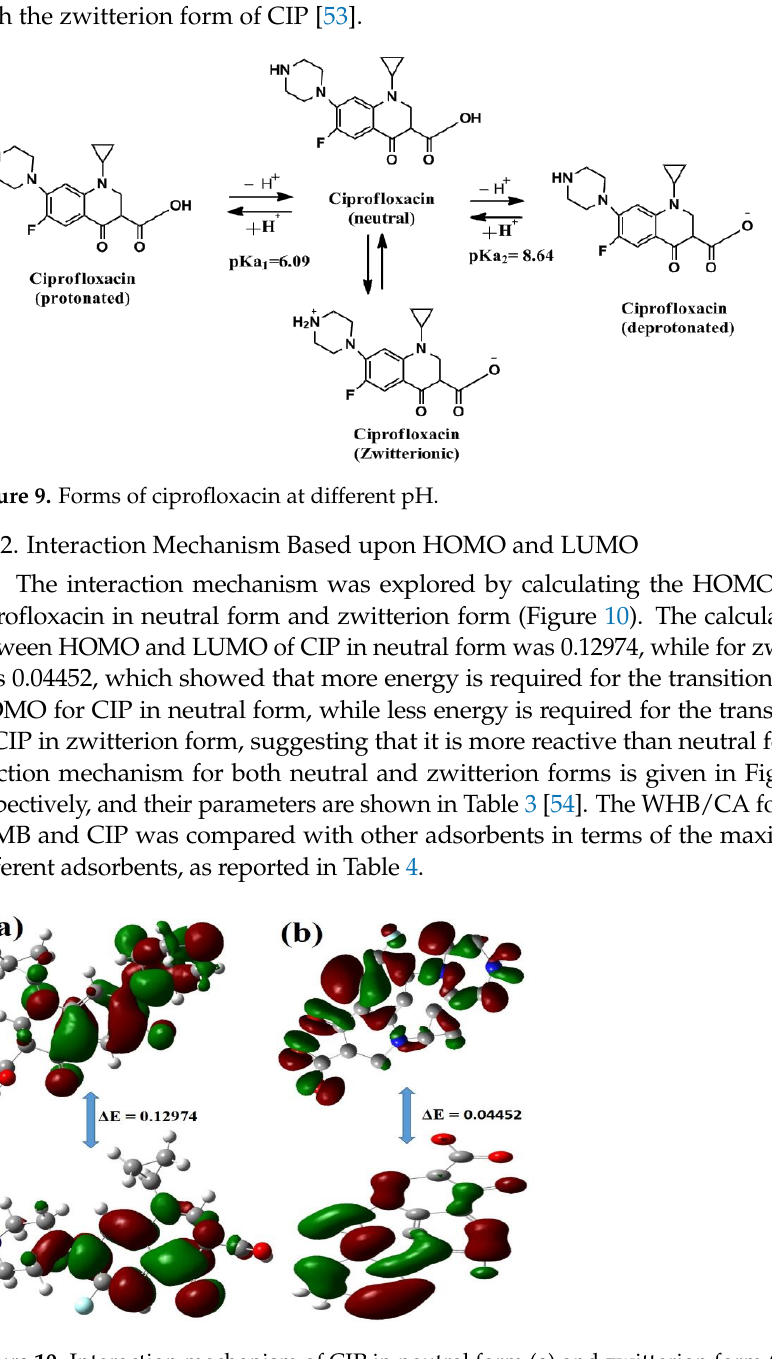
Figure 11. Interaction of CIP in neutral form with modified biochar.